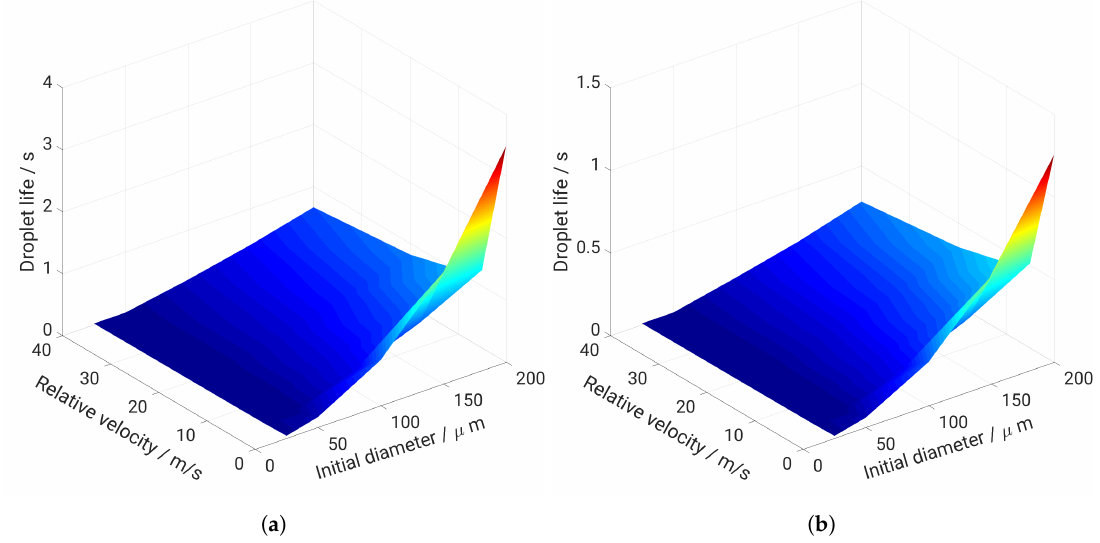
Figure 8. Droplet life with respect to various diameter and relative velocity for: ( a ) T g = 573 K; ( b ) T g = 773